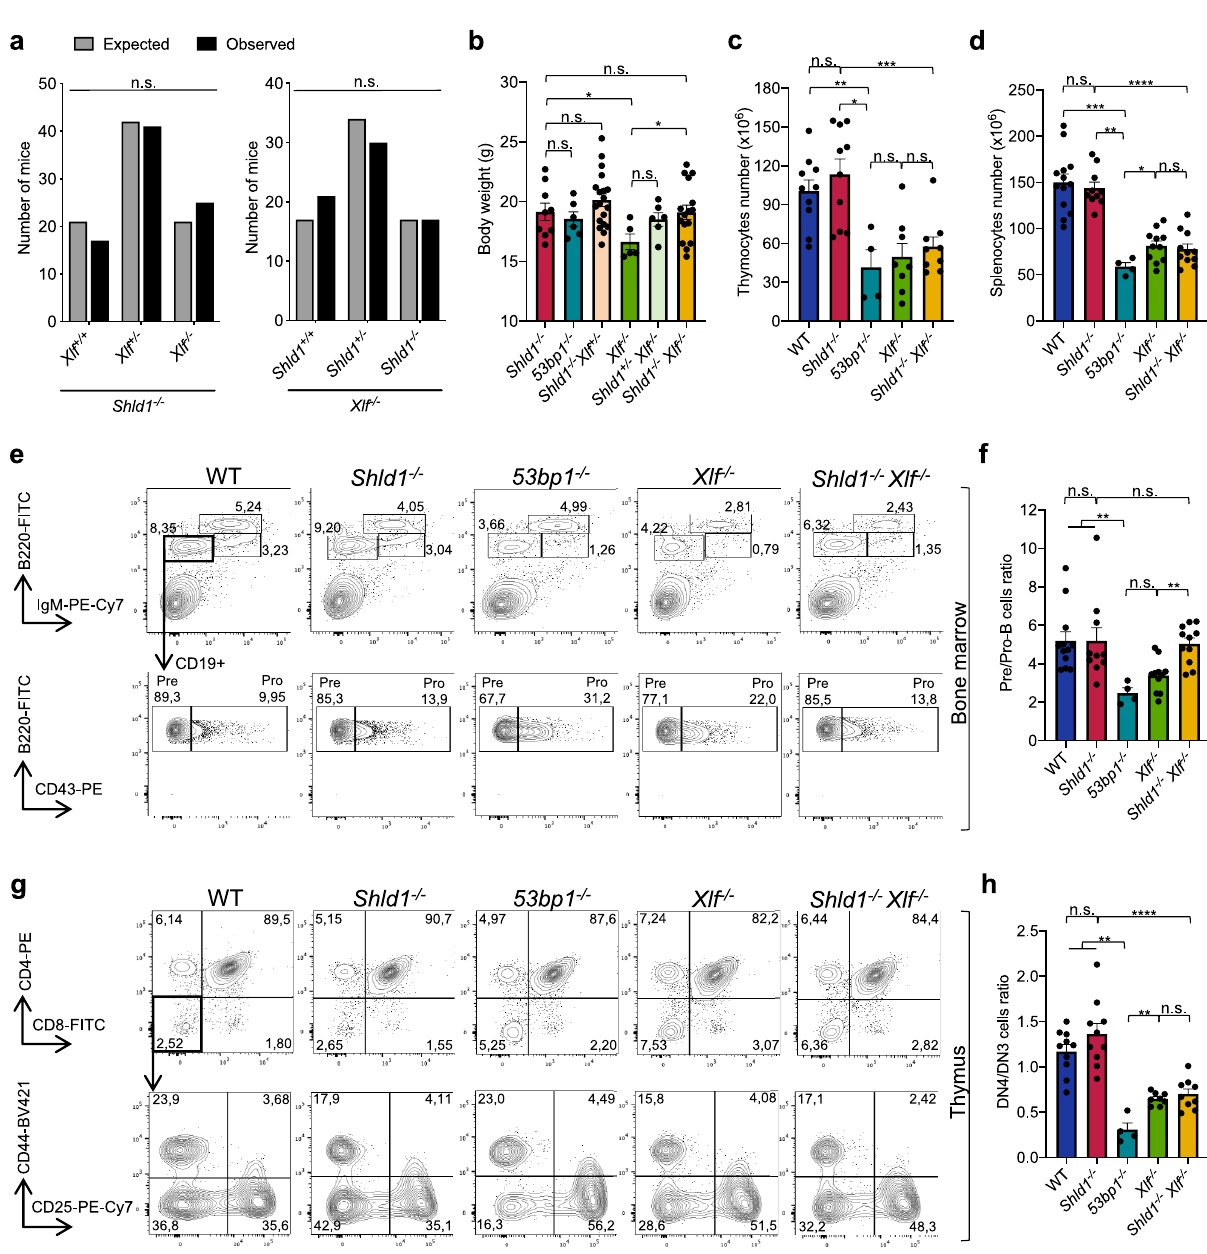
Fig. 1 Shld1 − / − and Shld1 − / − Xlf − / − mice are viable and show no overt developmental phenotype. a Number of live-born mice obtained from crosses between Shld1 − / − Xlf + / − mice (left) or Shld1 + / − Xlf − / − mice (right). Expected versus observed numbers were used to calculate one-sided Chi-square. Shld1 − / − Xlf + / − cross: n = 83 observed live-born mice; Shld1 + / − Xlf − / − cross: n = 68 observed live-born mice. b Total body weight (in grams) of adult mice (males and females, 6 – 8-week-old) from the different genotypes as indicated. Bars represent mean ± s.e.m., n = 9 independent mice ( Shld1 − / − ), n = 6 ( 53bp1 − / − ), n = 19 ( Shld1 − / − Xlf + / − ), n = 5 ( Xlf − / − ), n = 6 ( Shld1 + / − Xlf − / − ), n = 16 ( Shld1 − / − Xlf − / − ), two-sided Wilcoxon – Mann – Whitney test (* p = 0.047 ( Xlf − / − vs Shld1 − / − ); *p = 0.0268 ( Xlf − / − vs Shld1 − / − Xlf − / − )). c Total thymocytes numbers. Bars represent mean ± s.e.m., n = 10 (WT; Shld1 − / − ), n = 4 ( 53bp1 − / − ), n = 8 ( Xlf − / − ), n = 9 ( Shld1 − / − Xlf − / − ), two-sided Wilcoxon – Mann – Whitney test (* p = 0.014; ** p = 0.008; *** p =